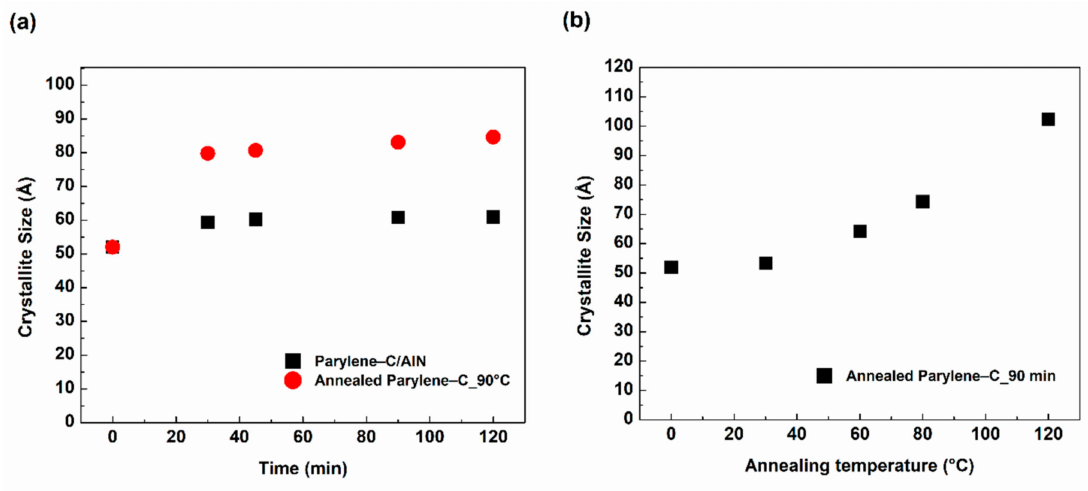
Figure 6. ( a ) Crystallite sizes of parylene-C/AlN and 90 ◦ C annealed parylene-C with respect to sputtering and annealing time, respectively. ( b ) Crystallite sizes of 30, 60, 80 and 120 ◦ C annealed parylene-C for 90